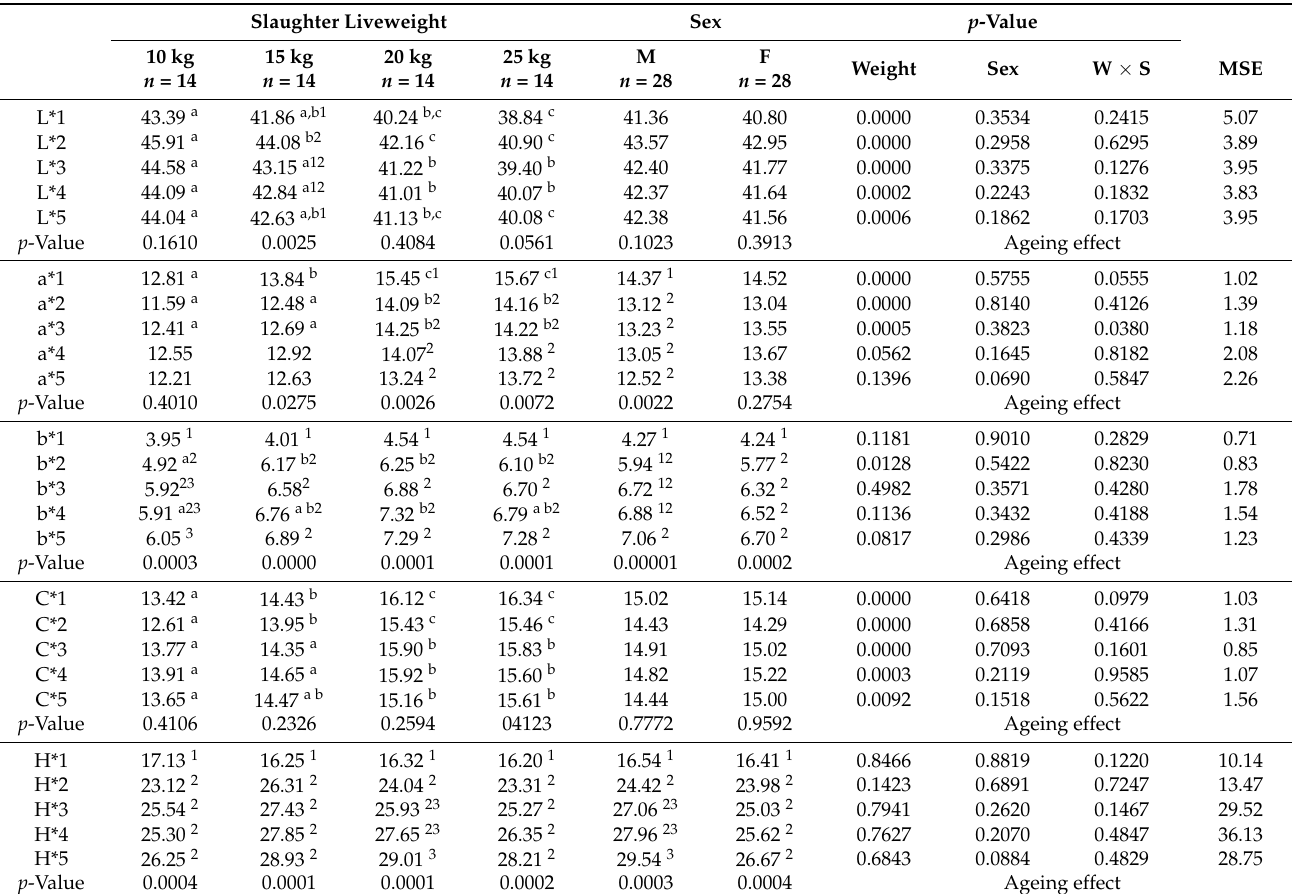
Table 2. Means and mean square errors of daily colorimetric parameters of LT muscle in the four weight groups and in male and female groups during the five days